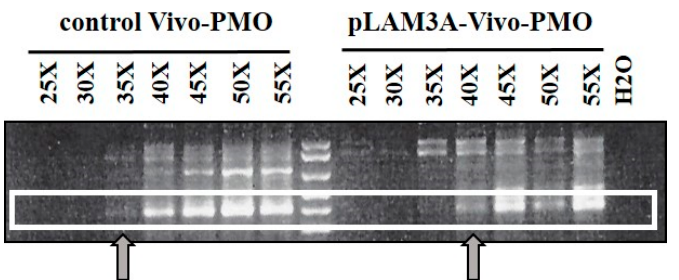
Figure 6. Evaluation of DUX4 mRNA expression in mouse tibialis anterior muscles co ‐ injected with rAAV ‐ D4Z4/pLAM virus and either pLAM3A or control vivo ‐ PMO. The TAs of the mice were injected with 1E11 DRP of D4Z4/pLAM AAV virus and 10 μ g of vivo ‐ PMO per leg. The mice were sacrificed 10 days post ‐ injection, and total RNAs were extracted with Trizol. Reverse transcription